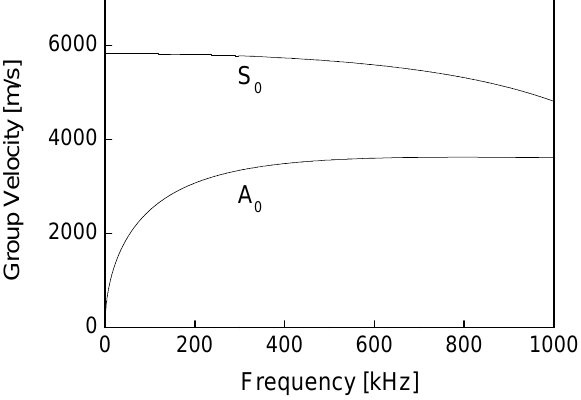
Figure 7 . Dispersion curves of the S CFRP